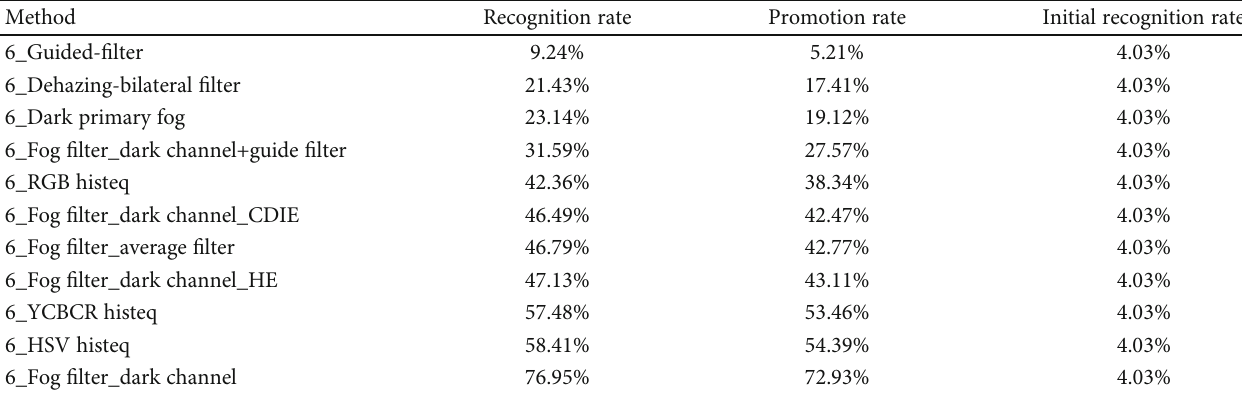
Table 2: Comparison table of the low-visibility target recognition e ff ect of di ff erent defogging algorithms.